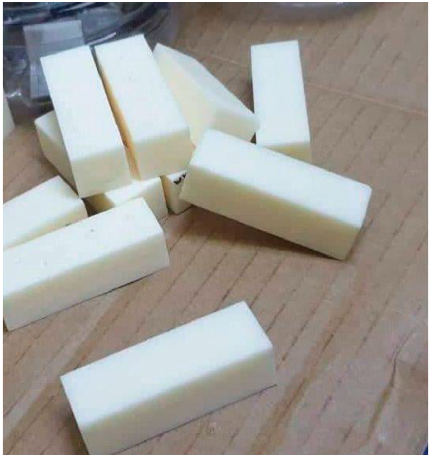
Figure 3: D1 artificial bone blocks made from solid rigid poly- urethane foam (SRPF) (#1522–23; Sawbones, Malm¨o,